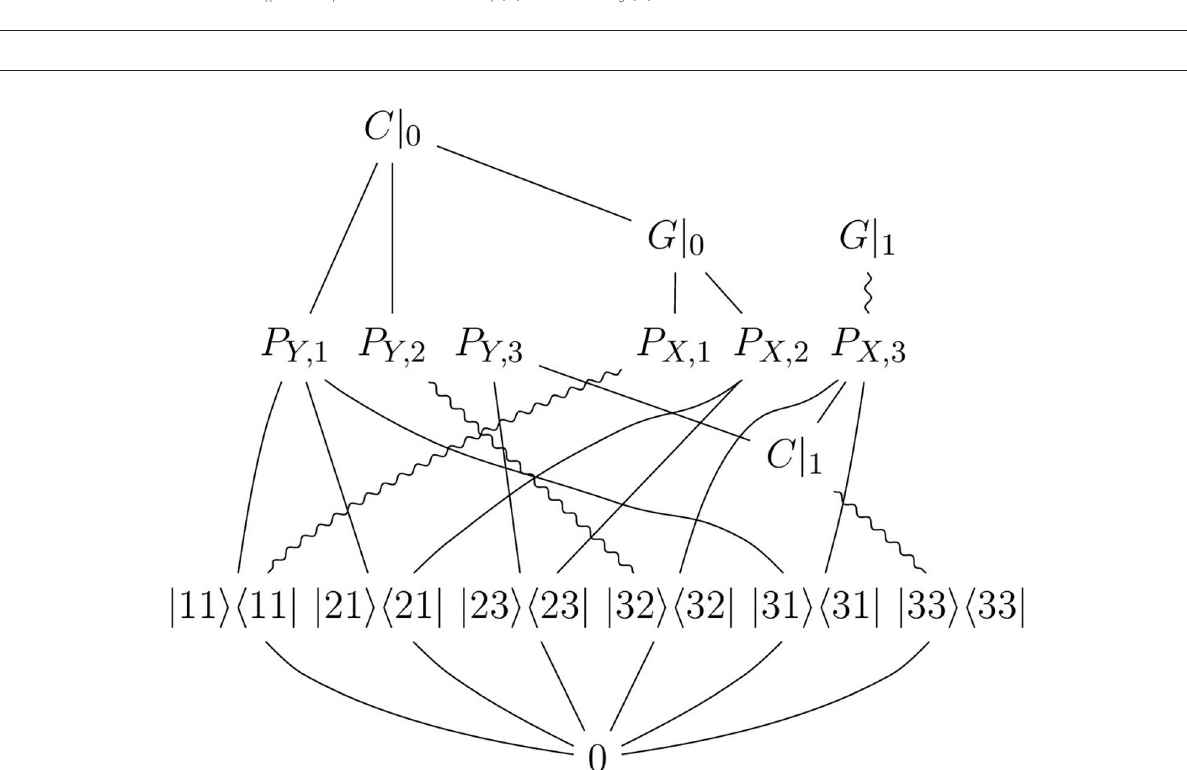
FIGURE11 The semantic structure after m 6 where the prediction of C | 1 needs P X ,3 and P Y ,3 and C | 0 can be predicted on parts of X , respectively, Y .